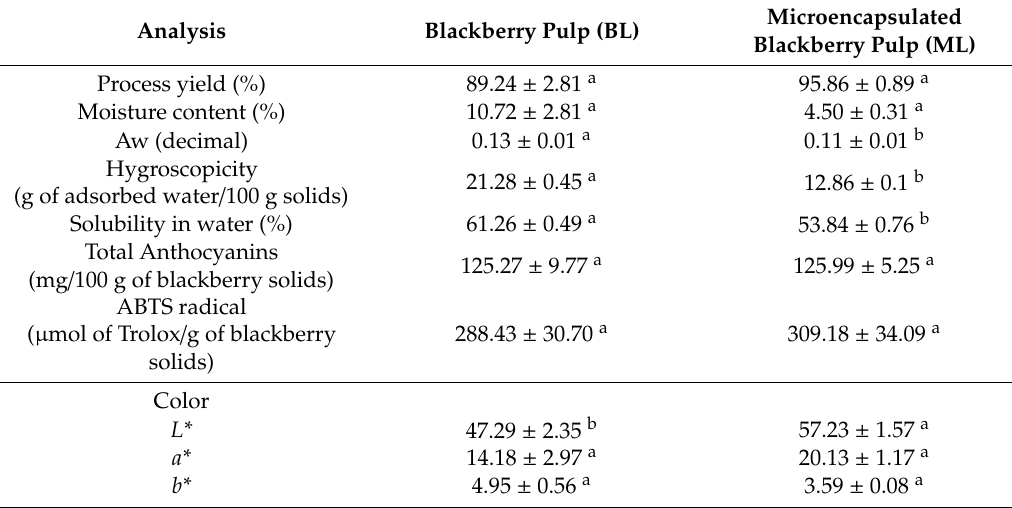
Table 1. Characterization of blackberry powder obtained by